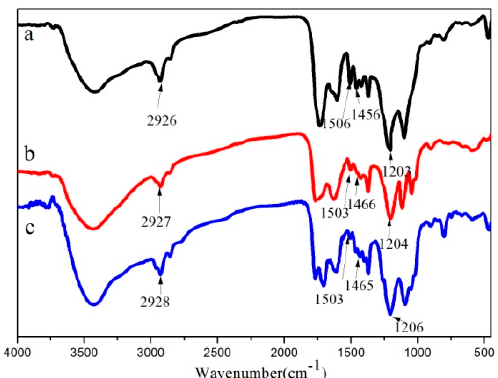
Figure 5. FTIR spectra of D-WSAL synthesized at 135 °C ( a ), 145 °C ( b ), and 155 °C ( c ) with 12:1 molar ratio of ICH to lignin for 3 h with 4 mL of DMF under nitrogen atmosphere. Table 3. Relative values of functional groups on D-WSALs synthesized at 135, 145, and 155 °C (phenyl group’s skeleton vibration peak at 1503 cm − 1 was selected as the reference, the relative values of other groups by area ratios of the peaks were calculated.)